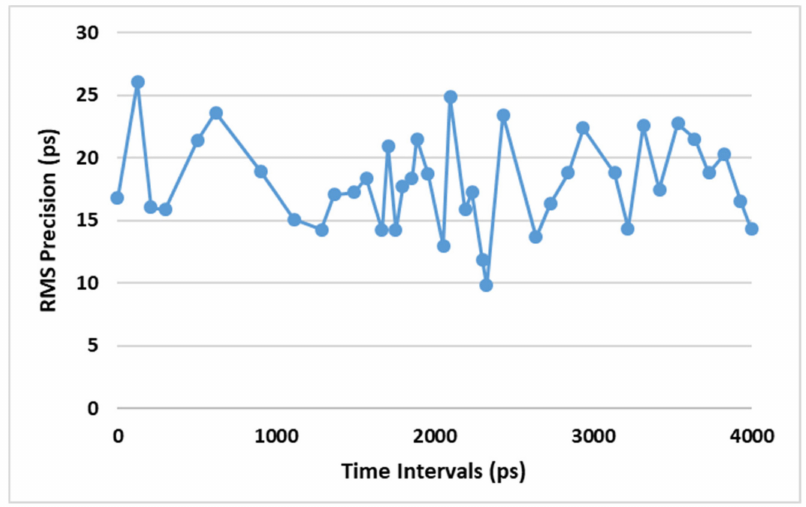
Figure 11. RMS precision of the different time